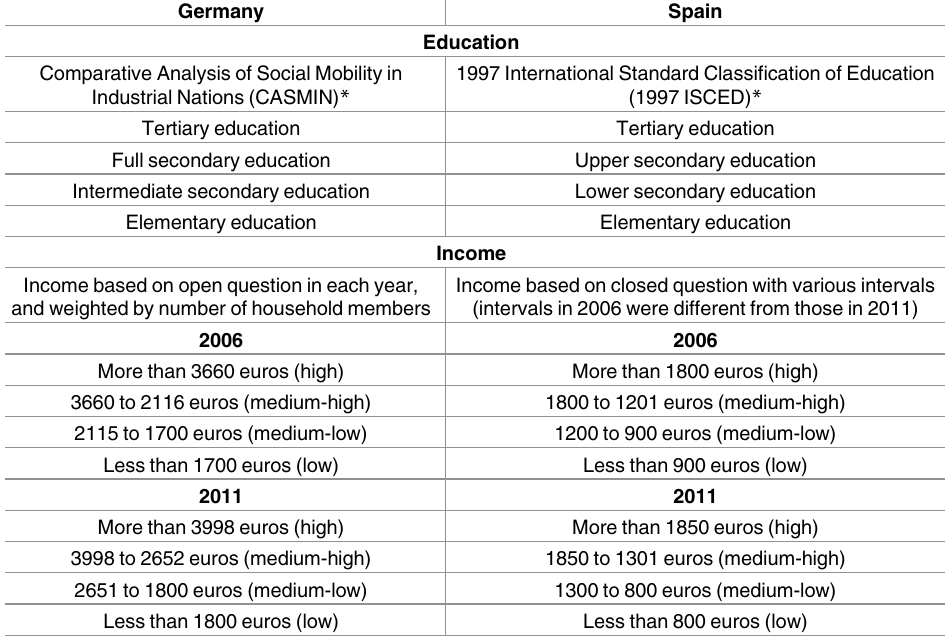
Table 1. Categories included in each indicator of socioeconomic